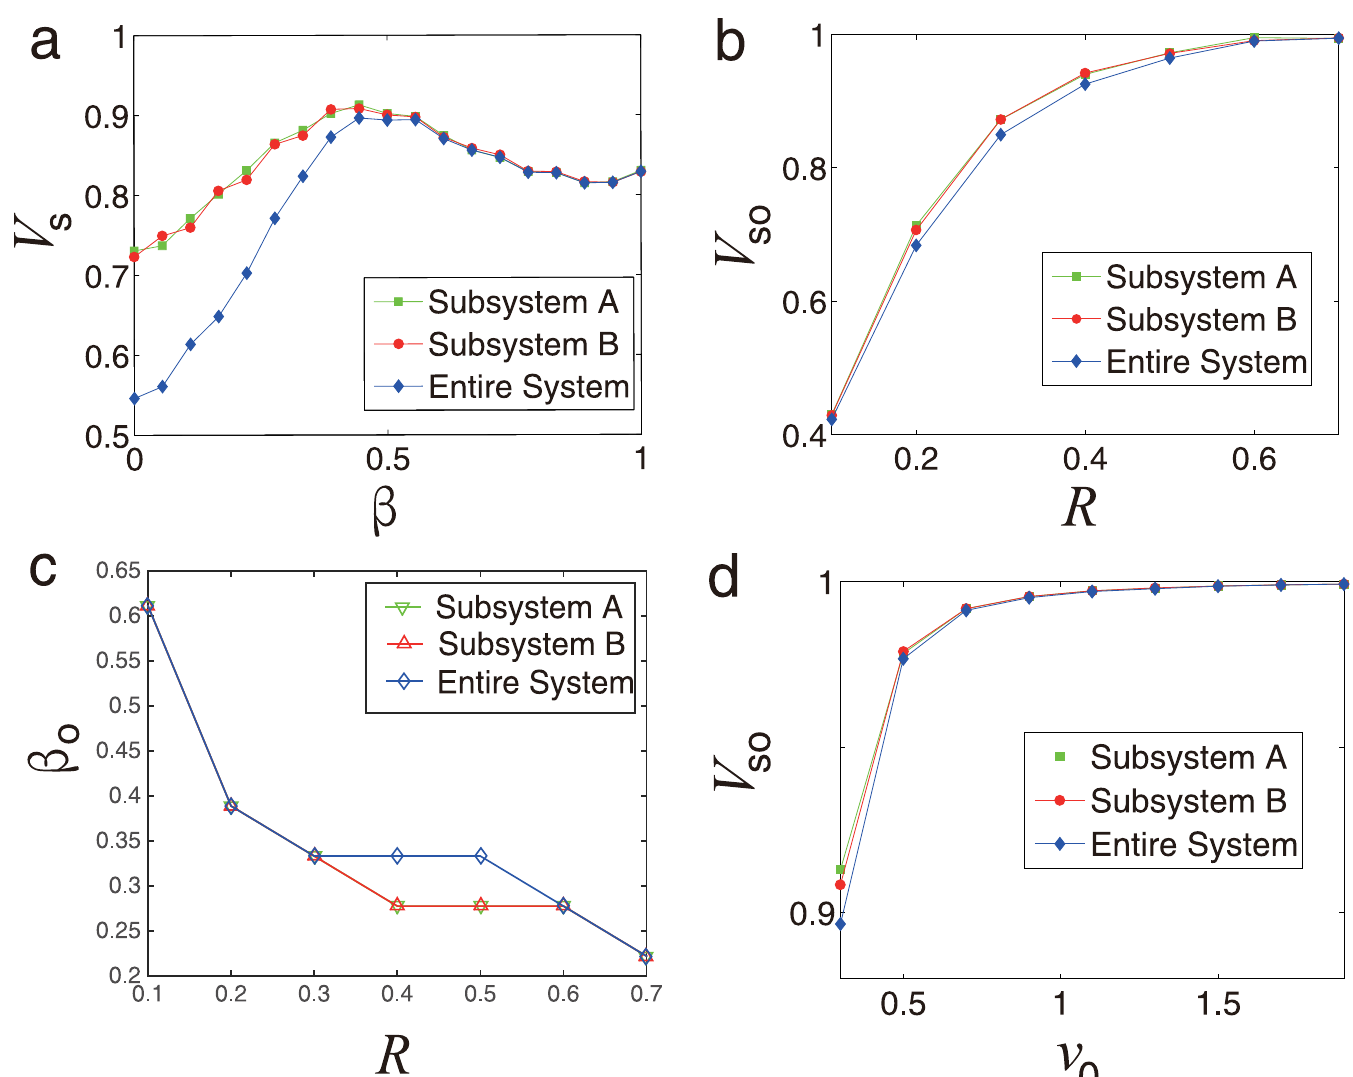
Fig 4. Absolute velocity and radius effect for symbiotic relationship. (a) Synchronization V s as a function of the coupling strength β for subsystem A, subsystem B and the entire system. (b) Optimal synchronization V so as a function of radius R for subsystem A, subsystem B and the entire system. (c) Optimal coupling strength β o as a function of radius R for subsystem A, subsystem B and the entire system. (d) Optimal synchronization V so as a function of the absolute velocity v 0 for subsystem A, subsystem B and the entire system. The simulation results are saved in S2 and S3 Files.